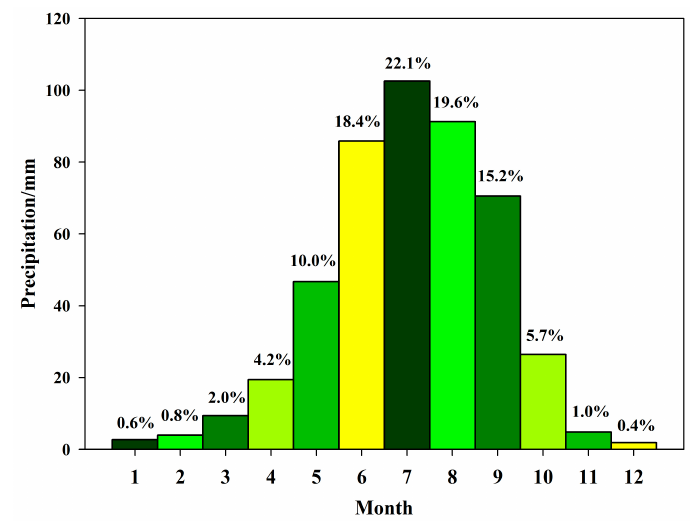
Figure 2. The precipitation distribution in each month on the TP during 1961–2015.